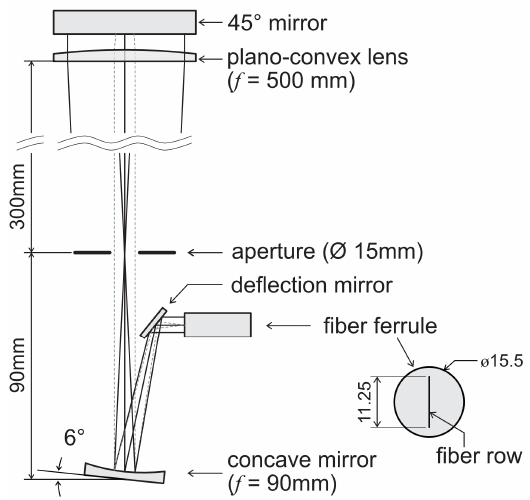
Figure 3. Schematic illustration of the optical setup of the telescopes. Using a concave mirror instead of a plano-convex lens minimizes chromatic aberrations in multi-wavelength operation.